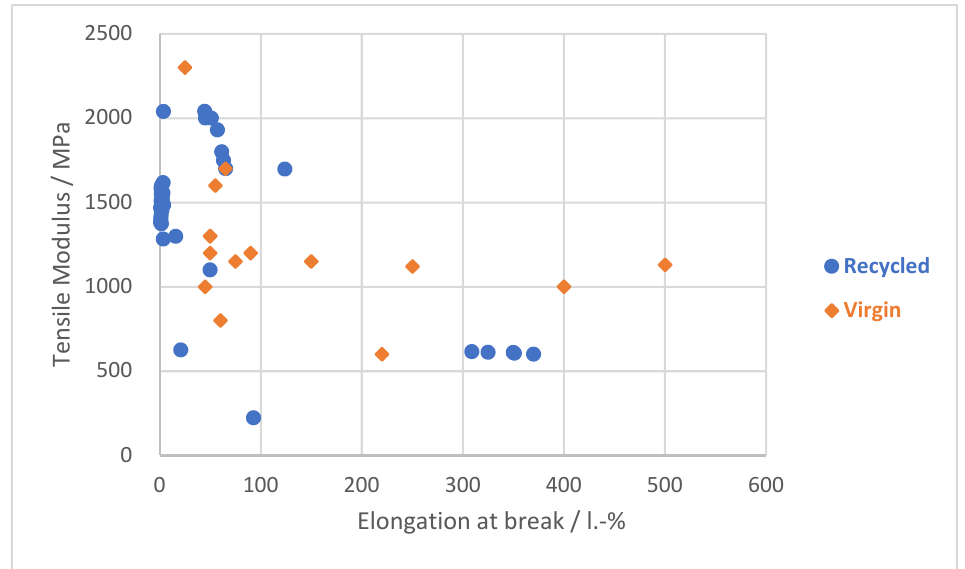
Figure 7. Tensile modulus and elongation at break values of R-PP and V-PP.